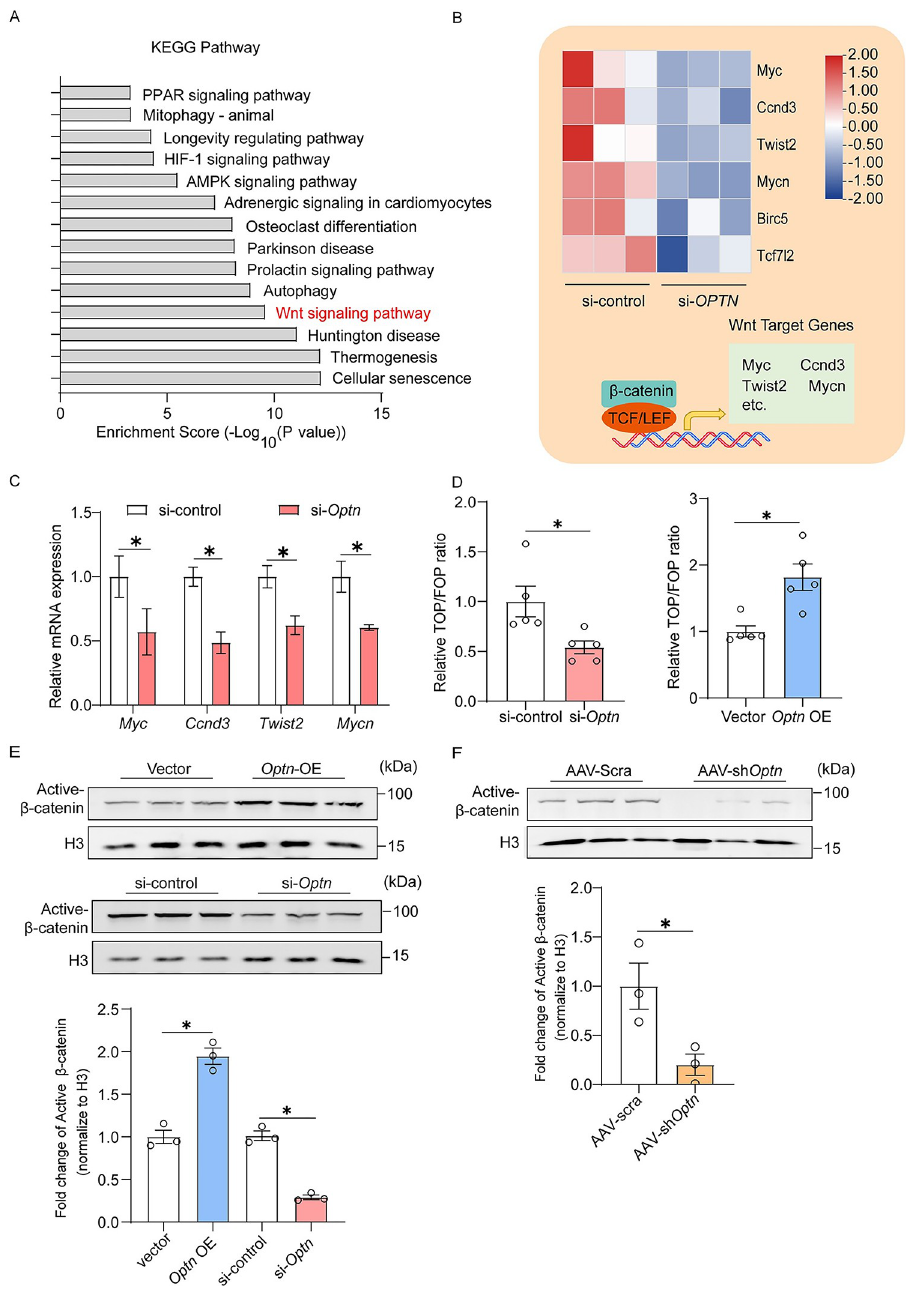
Fig 3. OPTN activates canonical Wnt signaling pathway in myoblasts. (A) KEGG pathway enrichment analysis in si- Optn Hela cells from the GEO dataset (GSE6819). (B) Heatmap of the changes in selected Wnts target genes expression levels in si-control and si- OPTN Hela cells by RNA-seq from the GEO dataset (GSE6819). (C) Representative mRNA expression analysis of Wnt target genes in si-control or si- Optn C2C12 cells at 4 days postdifferentiation ( n = 3 in each group). (D) Representative luciferase activity of TOP/FOP in Optn -KD (left panel) and Optn -OE (right panel) C2C12 cells at 4 days postdifferentiation ( n = 5 in each group). (E, F) Representative immunoblotting analysis and quantification of active β -catenin protein levels in nuclear lysates extracted from Optn - OE and Optn KD C2C12 cells at 4 days postdifferentiation (E) ( n = 3 in each group) and in nuclear lysates extracted from scramble shRNA or sh Optn TA muscle at 5 days postinjury (F) ( n = 3 mice in each group). Data are presented as mean ± SEM. � P < 0.05 versus control. The underlying data for this figure can be found in S1 Data . The original blot for this figure can be found in S1 Raw Image . AAV, adeno-associated viral vector; AMPK, AMP-activated protein kinase; Birc5, baculoviral IAP repeat containing 5; Ccnd3, cyclin D3; GEO, Gene Expression Omnibus; HIF,